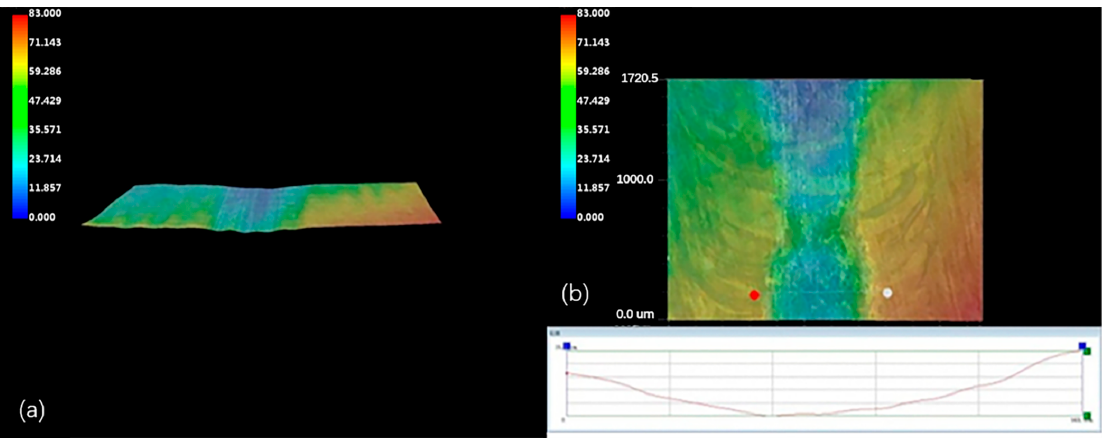
Figure 7. Three-dimensional morphology of wear surface: ( a ) front view; ( b ) vertical view. The wear volume 𝑉 (cid:3024) and the specific wear rate 𝐾 can be calculated from the Equa- tions (1) and (2) [27].